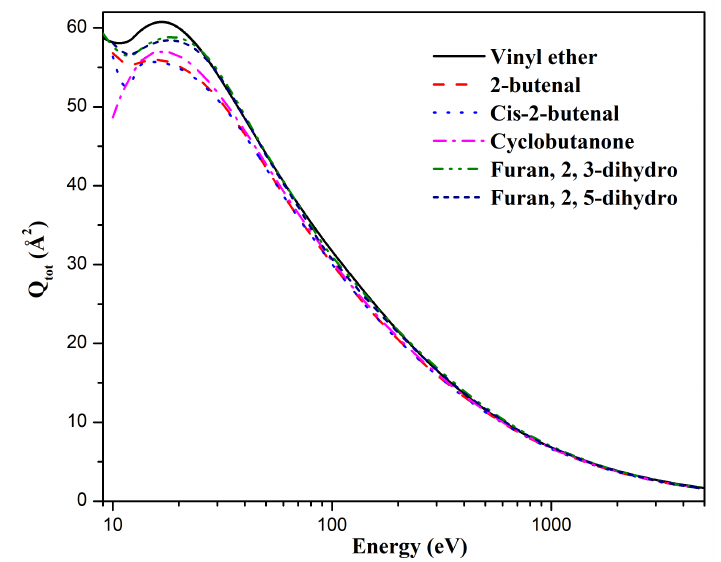
Figure 9. Q tot for vinyl ether and its isomers. Solid line: present Q tot for vinyl ether; dash line: present Q tot for 2-butenal; dotted line: present Q tot for cis-2-butenal; dash-dot line: present Q tot for cyclobutanone; dash-dot-dot line: present Q tot for furan, 2, 3-dihydro; short dash line: present Q tot for furan, 2,